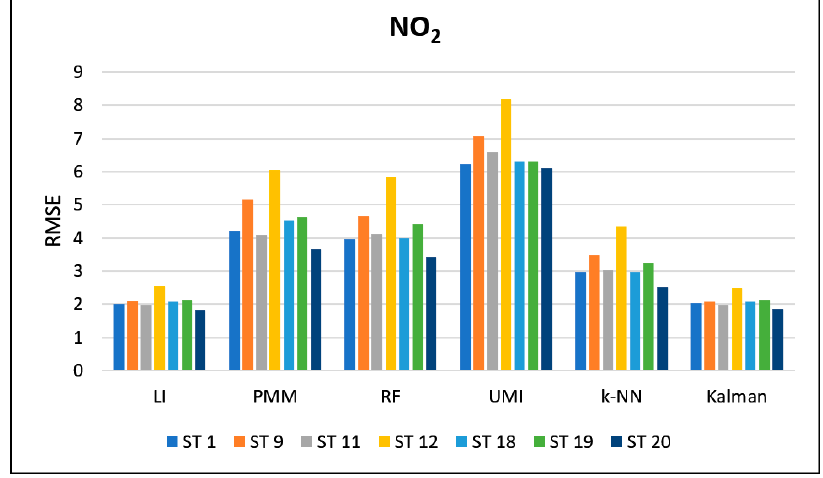
Figure 7. RMSE error for NO 2.